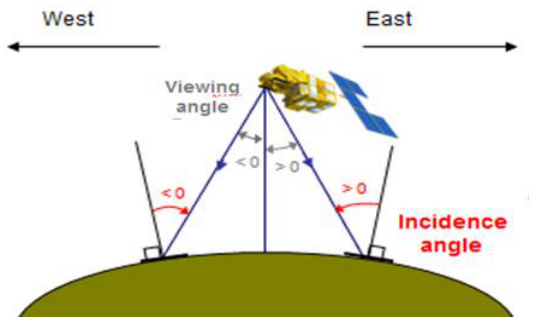
Figure 2. Representation of Viewing and Incidence angles (Courtesy of ASTRIUM DS France).